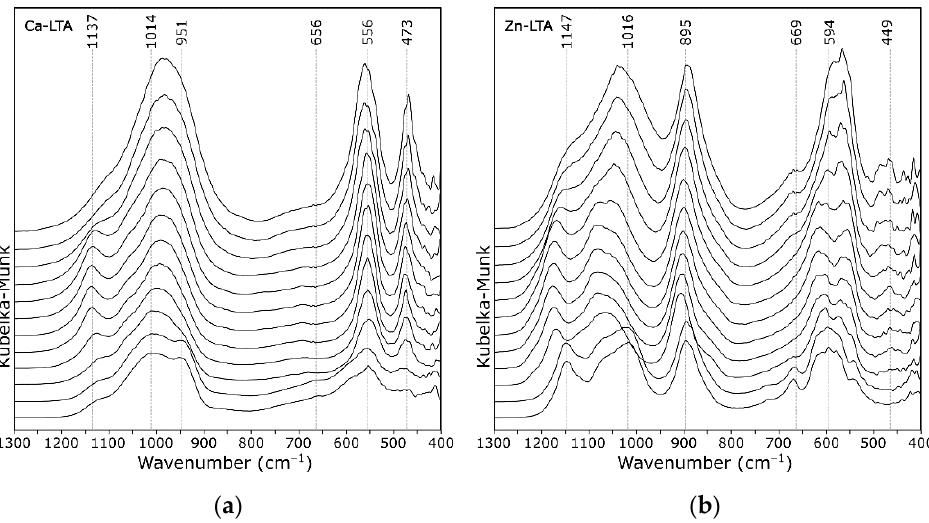
Figure 7. DRIFT spectra of zeolite A recorded at 50 °C intervals (from 50 to 600 °C): ( a ) Ca-A; and ( b ) Zn-A.